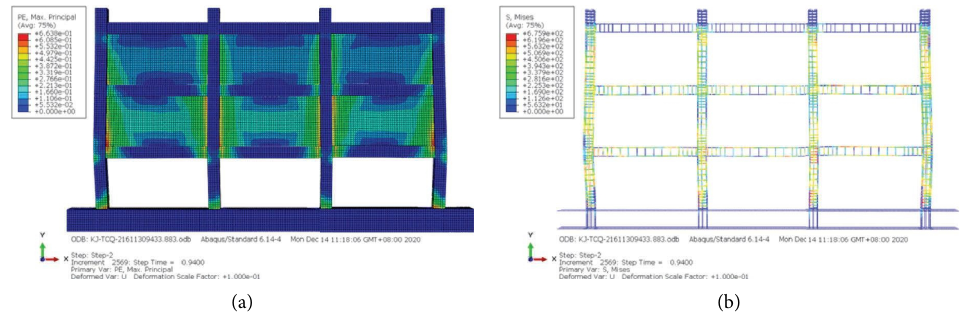
Figure 18: Specimen KJ-T-5. (a) Concrete plastic strain contour. (b) Steel bar stress contour.